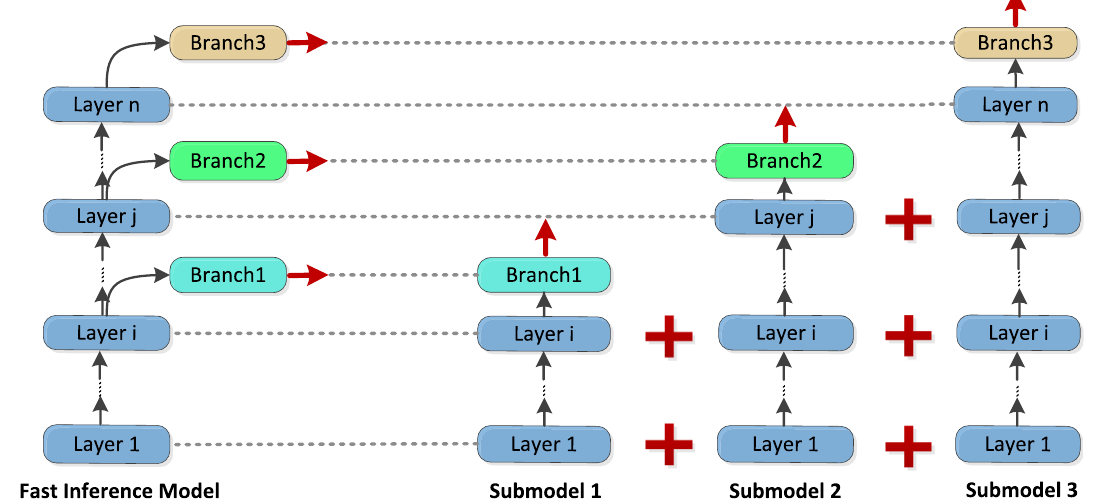
Fig. 1 The process of splitting a fast inference